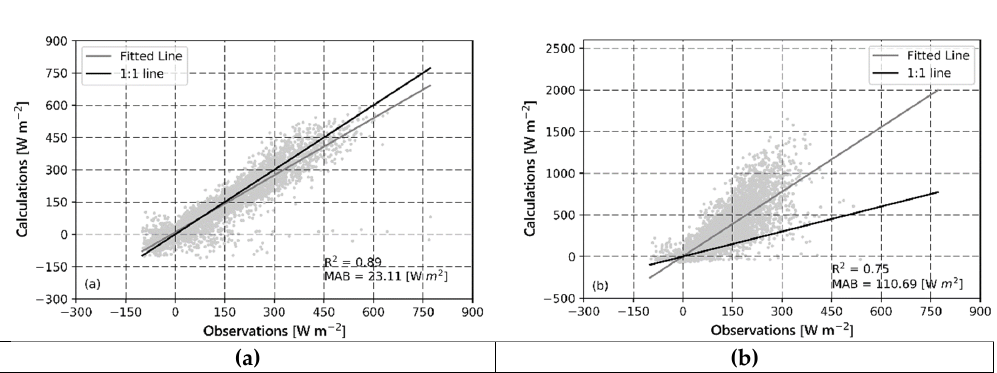
Figure 3. Turbulent fluxes estimated using the best possible estimation with the bulk method compared to observations ( ε = 0.95, Δ RH max = 5%, and C 1 = 0.7): ( a ) Sensible Heat Flux, ( b ) Latent Heat Flux ( p < 0.01 for both correlations).